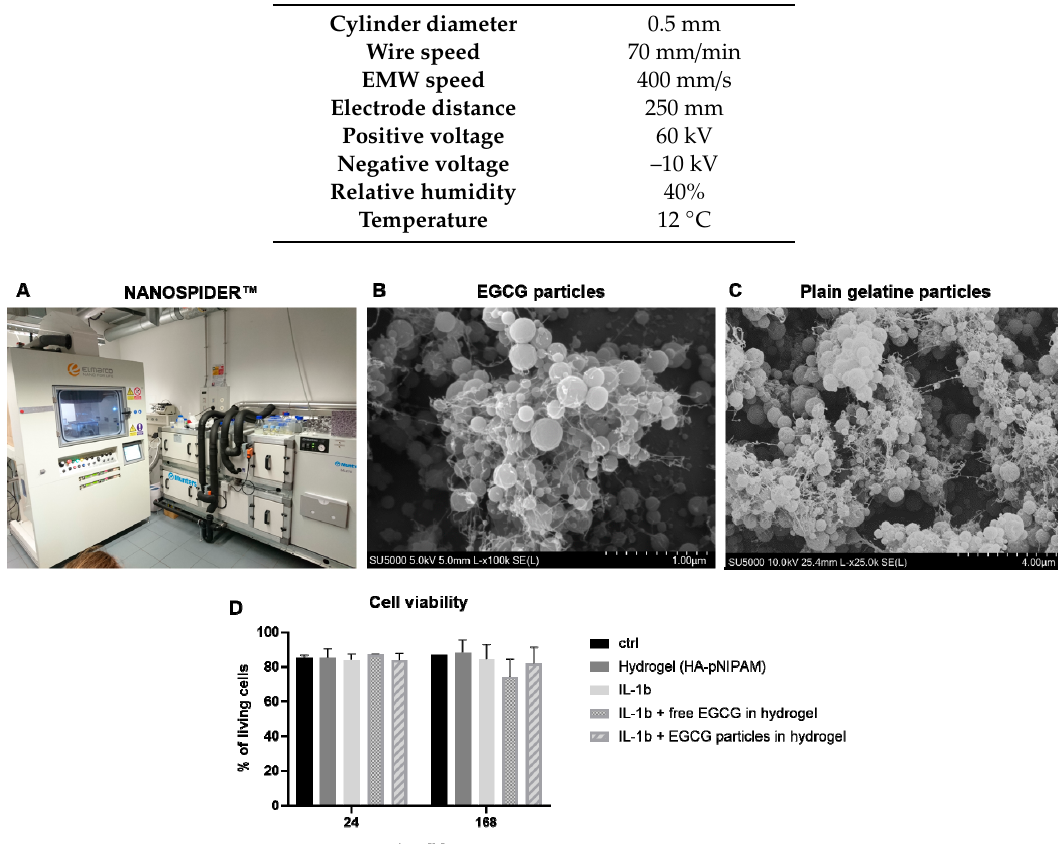
free EGCG in the hydrogel. Hydrogel alone and untreated beads were used as controls. Cell viability after 24 h and seven days was not significantly altered in either experimental group. Table 3. Final parameters chosen for electrospraying using NANOSPIDER ™ technology. Table 3. Final parameters chosen for electrospraying using NANOSPIDER™ technology.